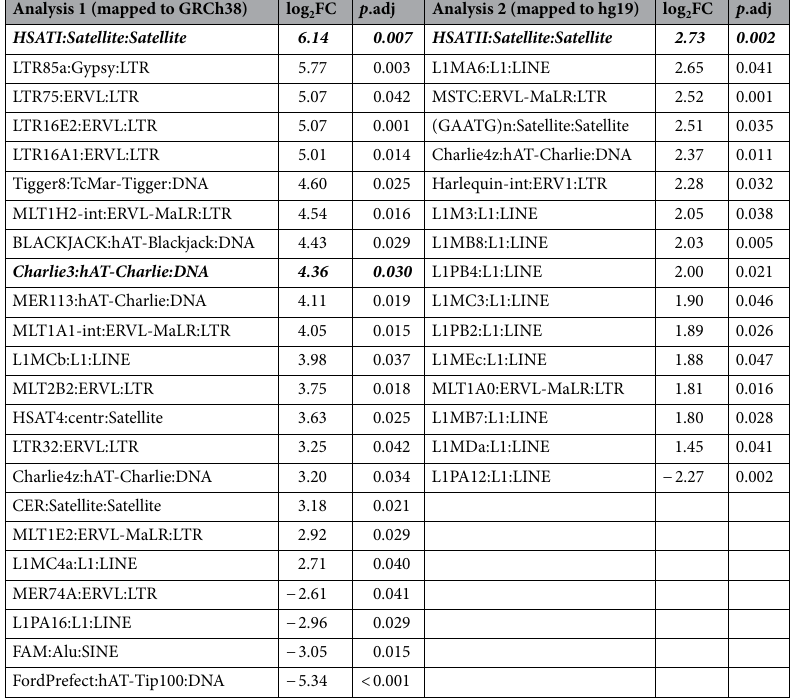
Table 2. Repeat elements significantly differentially represented in OS versus control EV preparations ( p . adj < 0.05; elements examined in the validation cohort in bold